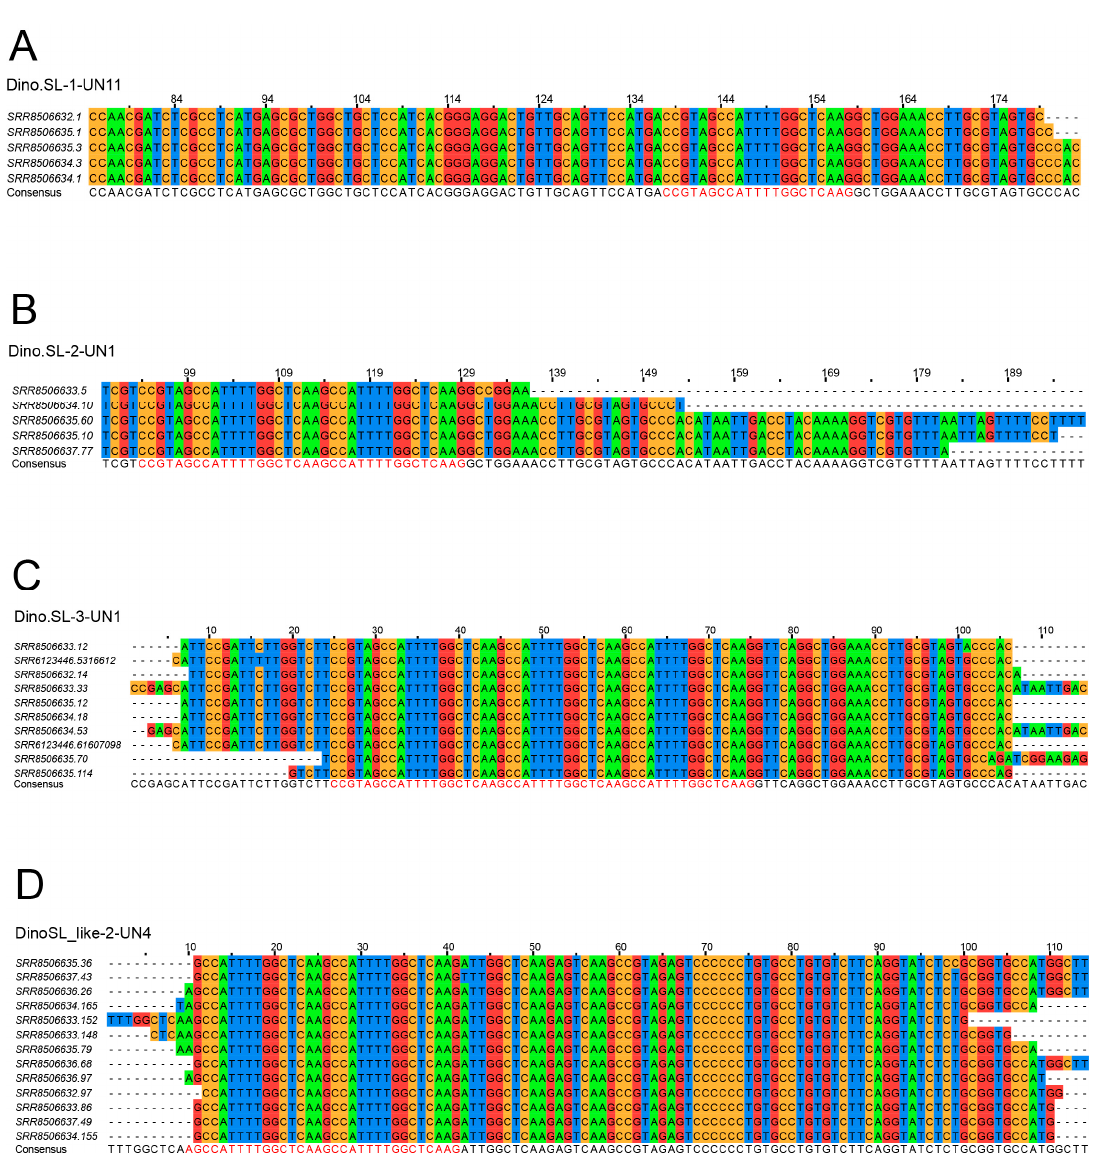
Figure 2. Alignment and assembly of SL-containing reads. The consensus sequence is shown at the bottom of each alignment. Examples include ( A ) single SL genes, and tandem SL genes with ( B ) two and ( C ) three units, and ( D ) an example of SL-like genes. The sequences of SL and its relicts were colored in red in the consensus sequences. More examples can be found in the Supplementary Figure 1.